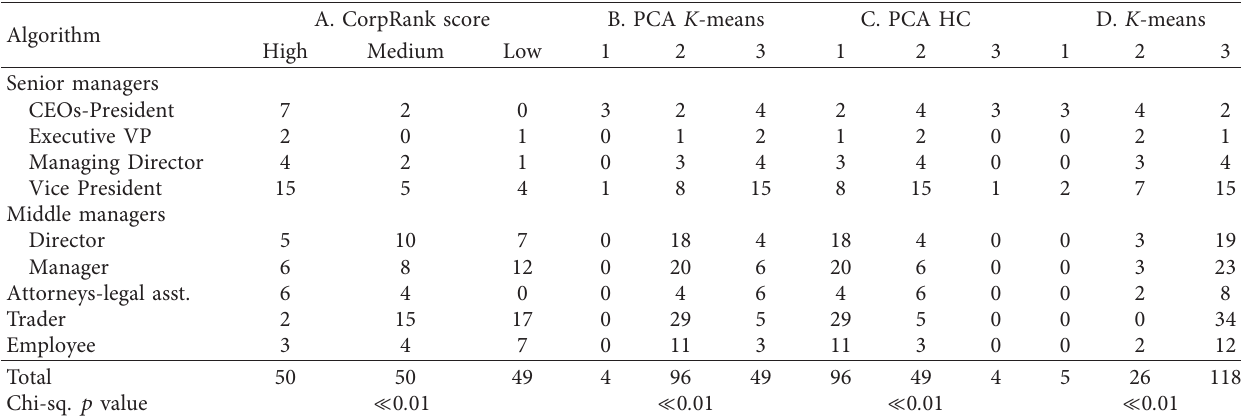
Table 6: Frequency of Enron’s employees in occupational categories by A. CorpRank score, B. PCA K -means, C. PCA hierarchical cluster (PCA HC), and D. K -means. Chi-square’s p value compares the results with the expected values assuming that there is independence between the occupational categories and the clusters generated by each algorithm.